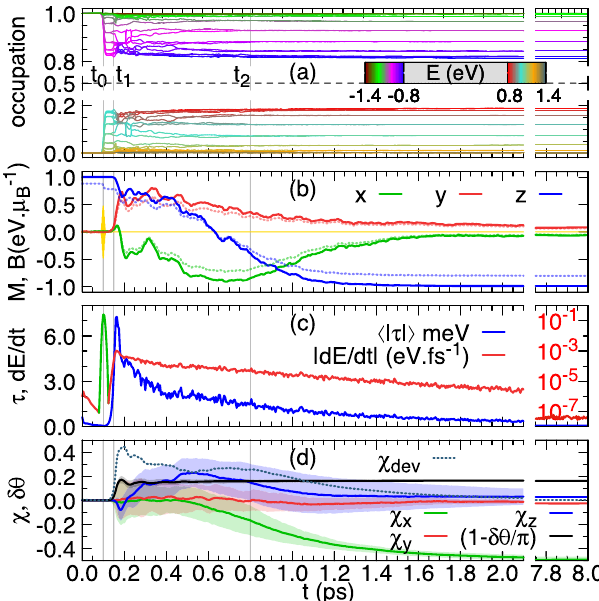
Fig. 2 Evolution of electron and spin subsystems over time. The laser hits at t = t 0 , the magnetisation dynamics starts at t = t 1 and the slow relaxation dynamics starts at t = t 2 . a Occupation of electronic states over time at half fi lling. The colours correspond to the eigenvalues (shown in inset). The black dashed line shows the average occupation which remains at 0.5. b Time evolution of magnetisation ^ M (solid) and effective fi eld B (transparent, dotted) for 17th site. Yellow line denotes the laser pulse. c Average magnitude of the torque ( hj τ ji ¼ 1 = N ∑ N i j μ B ^ M i ´ B i j in blue, scale on the left) and rate of change of energy (d E /d t , log 10 scale on the right). Green and red colours correspond absorption and dissipation of energy. d Evolution of average chirality components and relative angle over time. The shaded regions show the root mean square deviation.